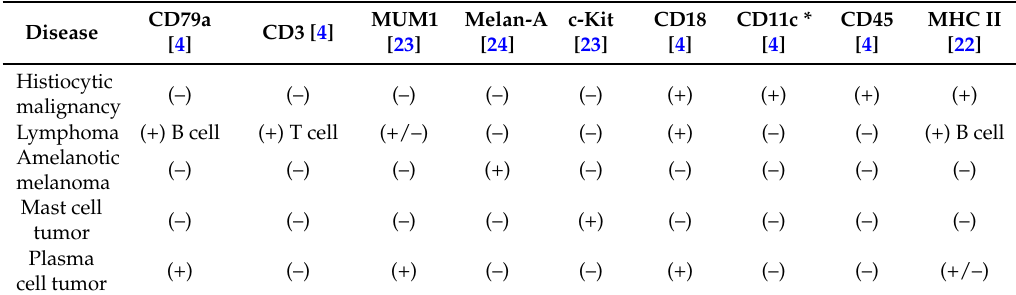
Table 1. Expression patterns of immunohistochemistry (IHC) markers in canine histiocytic malignancies (HM) and other round cell